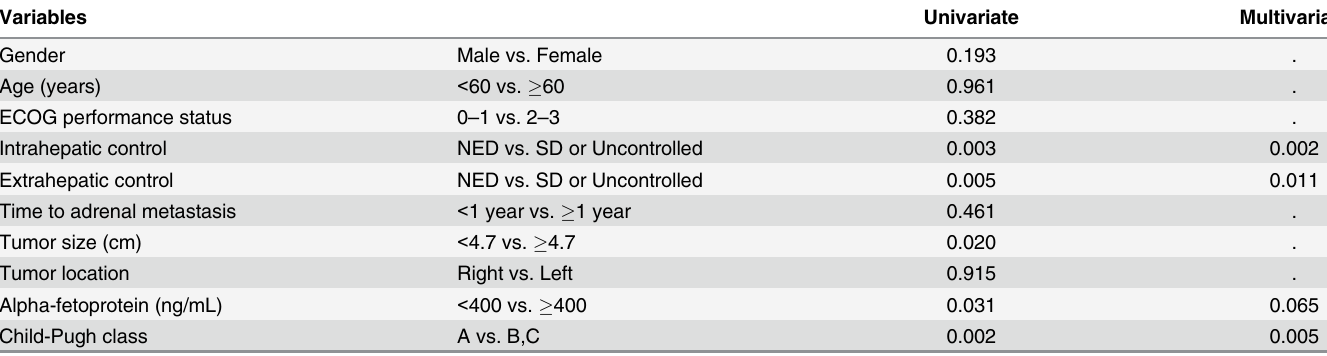
Table 3. Univariate and multivariate analysis of prognostic factors associated with overall survival. Variables Univariate